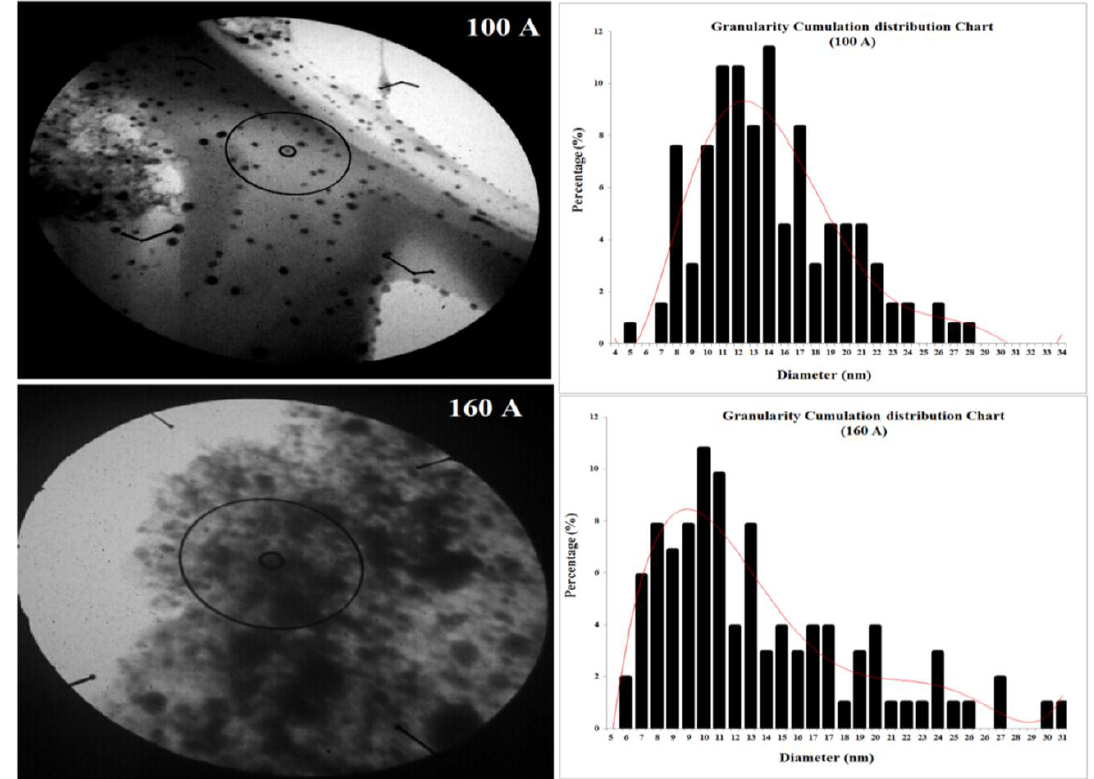
Fig. 5: TEM image and granulate accumulation for CuI nanoparticles prepared using 100 and 160 A